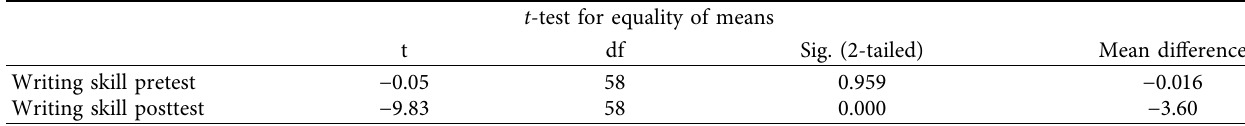
Table 21: Independent-sample test.